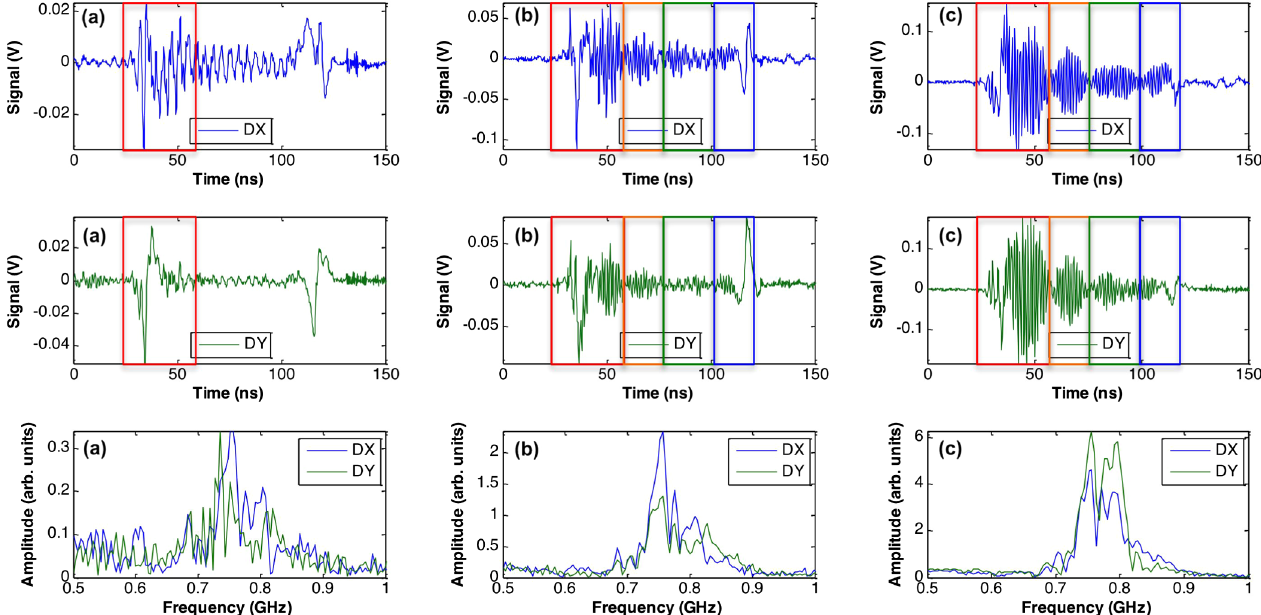
FIG. 10. Top row: unintegrated Δ x signals; middle row: unintegrated Δ y signals; bottom row: fast Fourier transforms of the signals above to indicate the amplitude and frequency of the BBU on the 2.9 kA beam measured at (a) BPM07 ( z ¼ 9 . 8 m); (b) BPM13 ( z ¼ 22 . 1 m); and (c) BPM19 ( z ¼ 34 . 3 m) (note scale differences). Color coded saturation regions are also